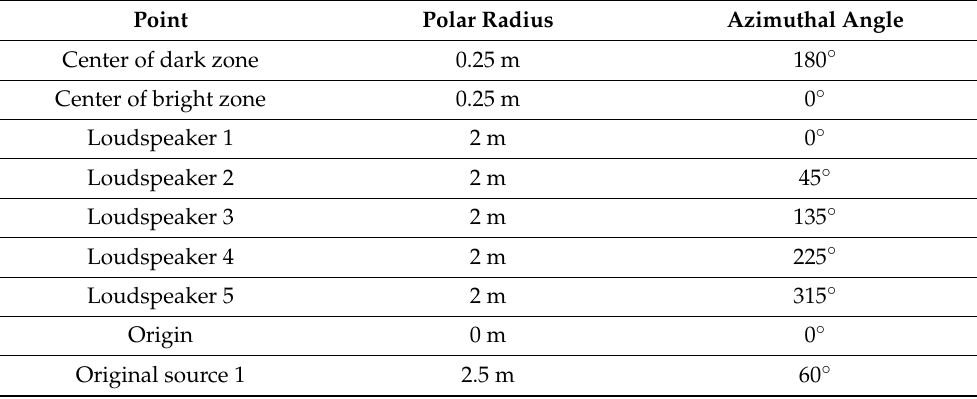
Table 2. The location of related points for experiment 2.